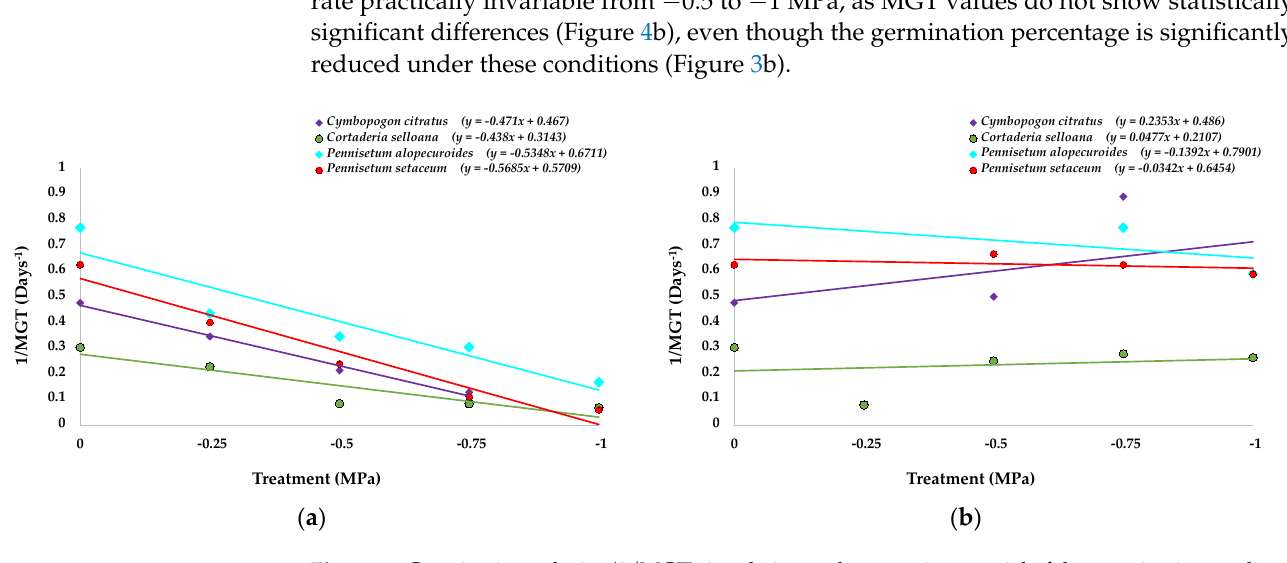
( d ) Figure 4. Mean Germination Time (MGT) of seeds of the four studied species after 30 days of the indicated PEG treatments (dark green), and after 20 days of “recovery” (light green). MGT in: ( a ) C. citratus , ( b ) C. selloana , ( c ) P. alopecuroides , and ( d ) P. setaceum . Control: germination in distilled water Values shown are means ± SE ( n = 4). Different lowercase letters within the bars indicate significant differences between treatments, for each species, according to the Tukey post hoc test ( p < 0.05). Other germination parameters (reduction in germination percentage; first germina ‐